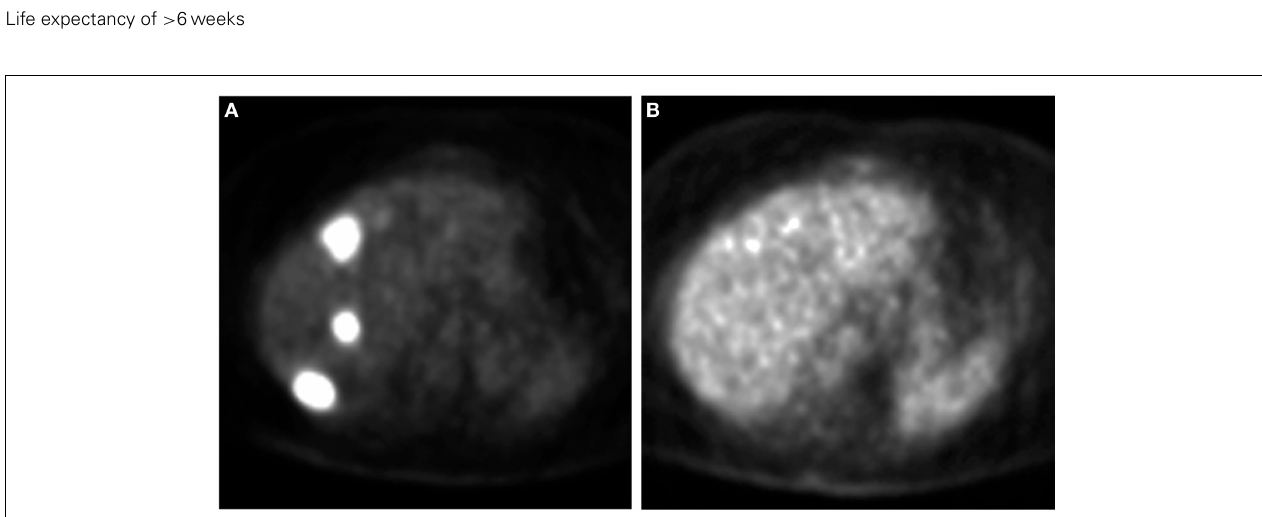
FIGURE 1 |Assessment of response toY-90 therapy on PET . A PET scan (A) obtained prior toY-90 therapy demonstrates three FDG avid lesions. A repeat PET scan (B) obtained 6weeks afterY-90 therapy shows no FDG avid lesions suggesting complete metabolic